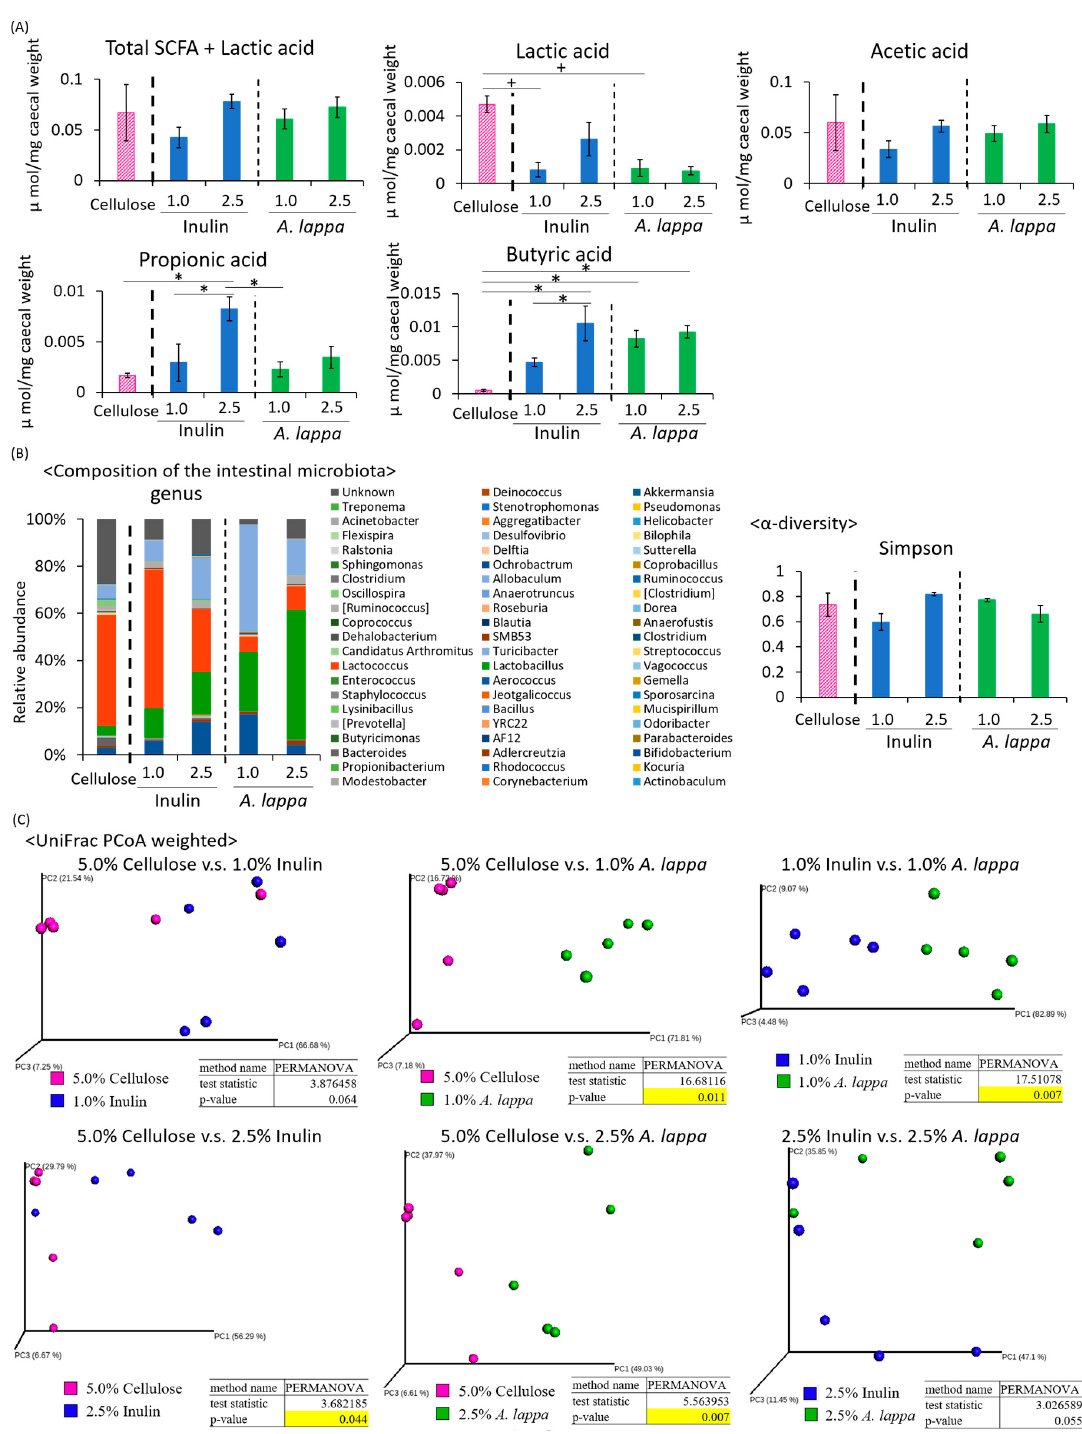
Figure 2. Comparing e ff ect of inulin and A. lappa intake on caecal SCFAs and feces microbiota in mice with HFD. E ff ect of several doses: HFD + 5.0% cellulose, 1.0% inulin, 2.5% inulin, 1.0% A. lappa , and 2.5% A. lappa on the intestinal microbiota. ( A ) SCFA component and lactic acid was measured from caecal contents by GC-FID. ( B ) Composition of the intestinal microbiota and α -diversity. ( C ) UniFrac principal coordinate analysis (PCoA) weighted intestinal microbiota. All data are represented as mean ± SEM ( n = 5 for each group). * p < 0.05, evaluated using the one-way ANOVA with Tukey post-hoc test. + p < 0.05, evaluated using the one-way ANOVA with a Kruskal–Wallis test and Dunn’s post-hoc